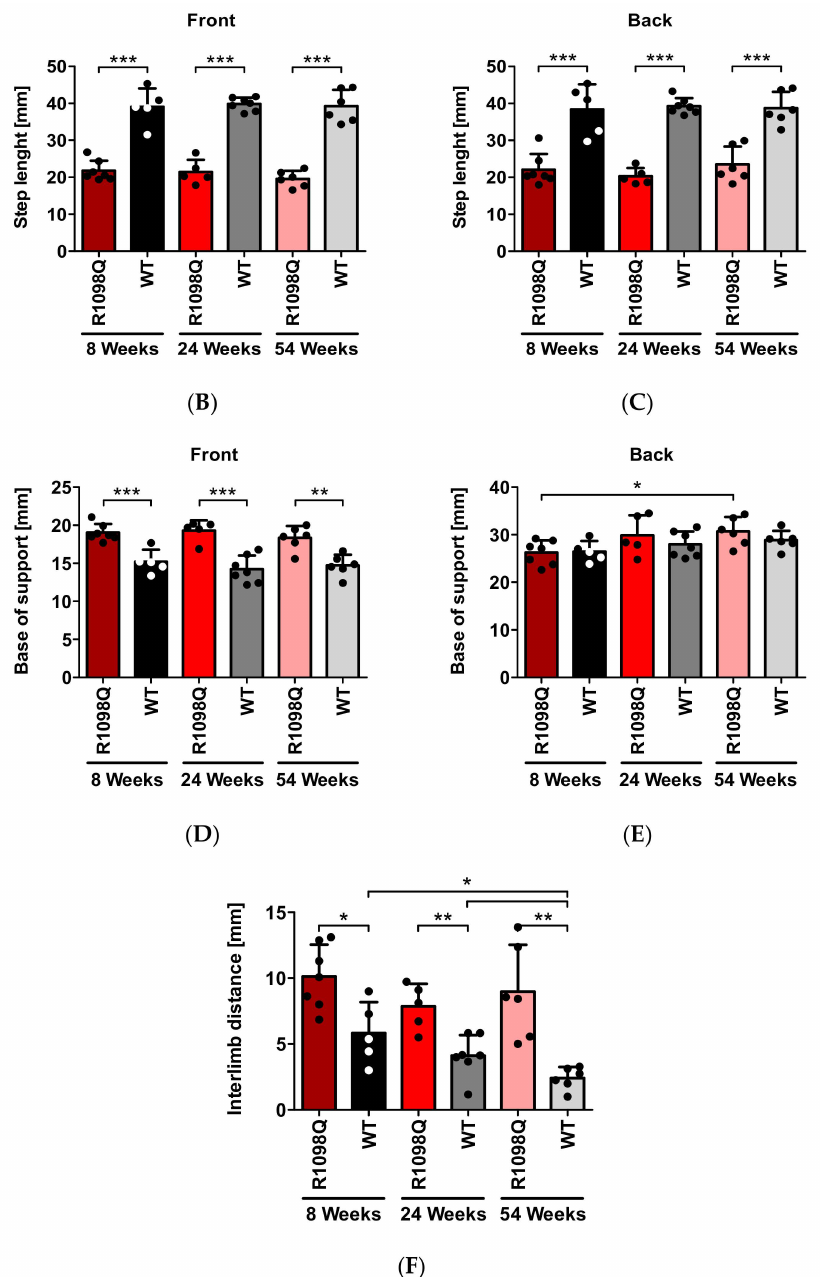
Figure 2. Footprint test. ( A ) Representative footprints of 54-week-old WT and R1098Q littermates (s.l.—step length, i.d.—interlimb distance, and BOS—base of support). Summary data showing a significant decrease in step length (front and back paws), ( B , C ) base of support ( D , E ), and an increase in the ( F ) interlimb distance between the R1098Q mice and WT controls. The test was performed on the 8-week-old group (WT, n = 5; R1098Q, n = 5), the 24-week-old) group (WT, n = 7; R1098Q n = 7), and the 54-week-old group (WT, n = 6; R1098Q, n = 6). The dots represent the mean measured distances. The bars represent the mean distance achieved by each group. Error bars represent standard deviations (SD). The statistics were calculated using the t -test. Statistically significant differences between R1098Q and WT mice, WT mice alone or R1098Q mice alone at different ages indicating the progression of the phenotype are marked with asterisks. (* p < 0.05, ** p < 0.01, and *** p <